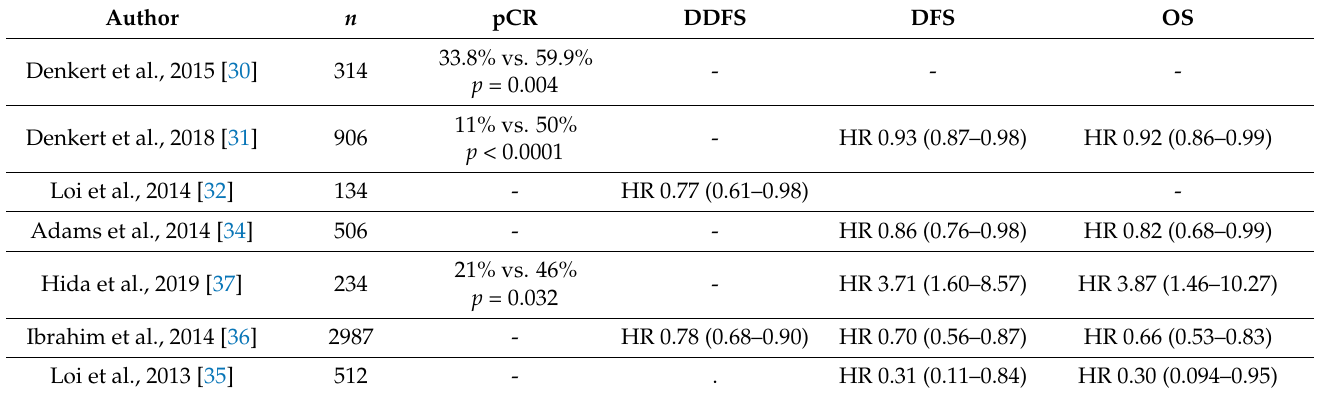
Table 1. Tumor-infiltrating lymphocytes in early triple-negative breast